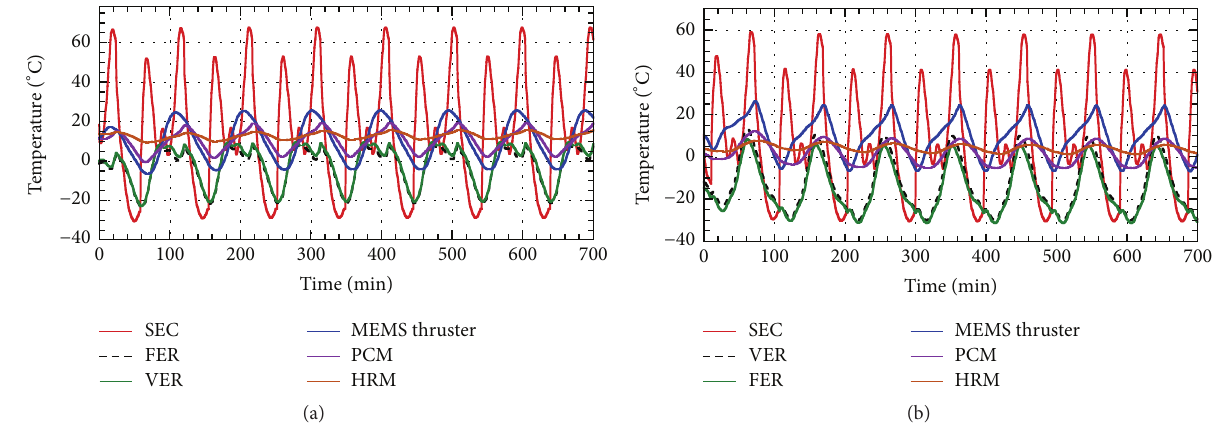
Figure 11: Temperature profiles of payloads ((a) worst hot case, (b) worst cold